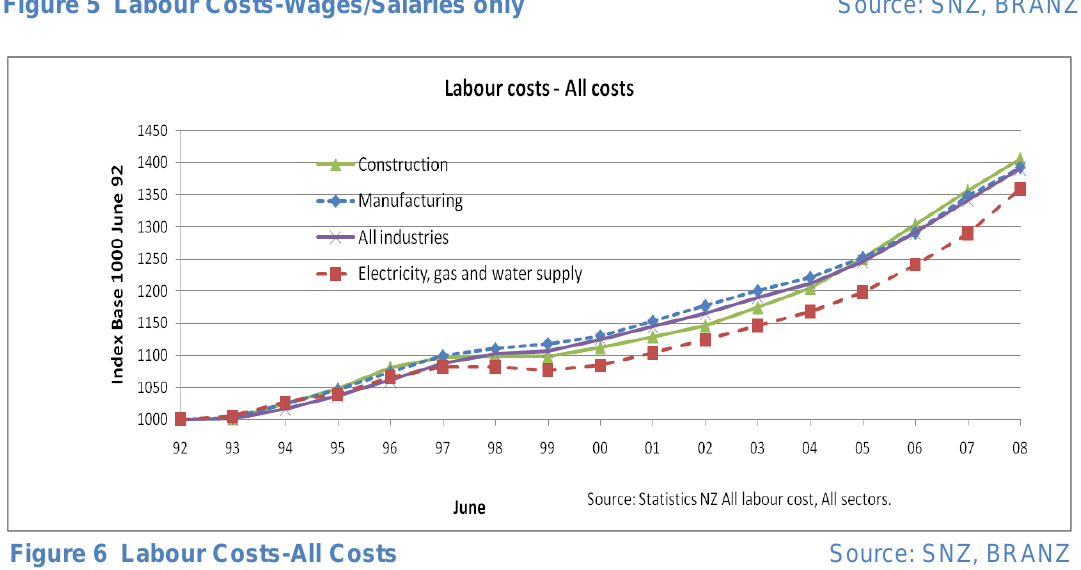
Figure 5 Labour Costs-Wages/Salaries only